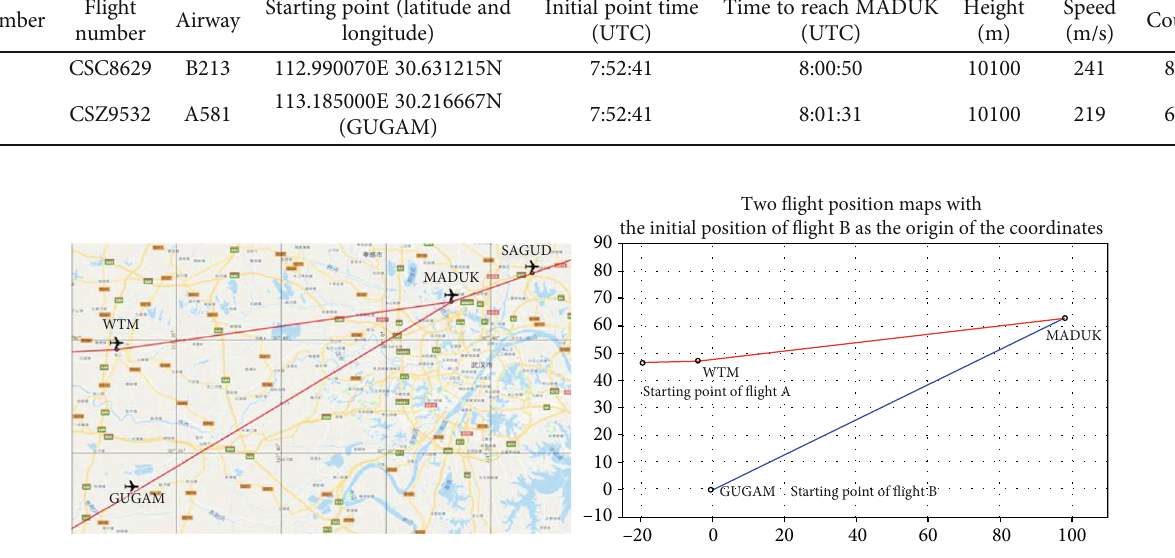
Figure 7: Two fl ight positions with the initial position of fl ight B as the coordinate origin.